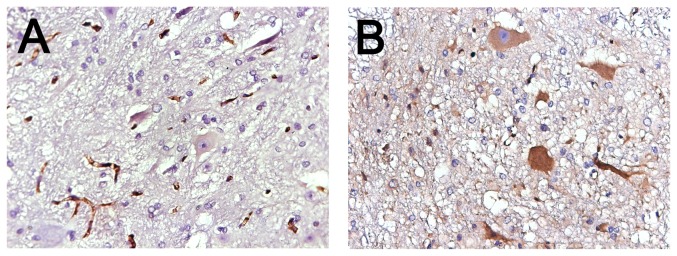
β2AR immunoperoxidase staining in the anterior horn of spinal cord.The positive regions were brown. (A) The sham group showed little β2AR expression in neurons. (B) The I/R group showed strong positive expression of β2AR in neurons (original magnification, 40× object lens). β2AR = β2 adrenergic receptor; I/R = ischemia-reperfusion.